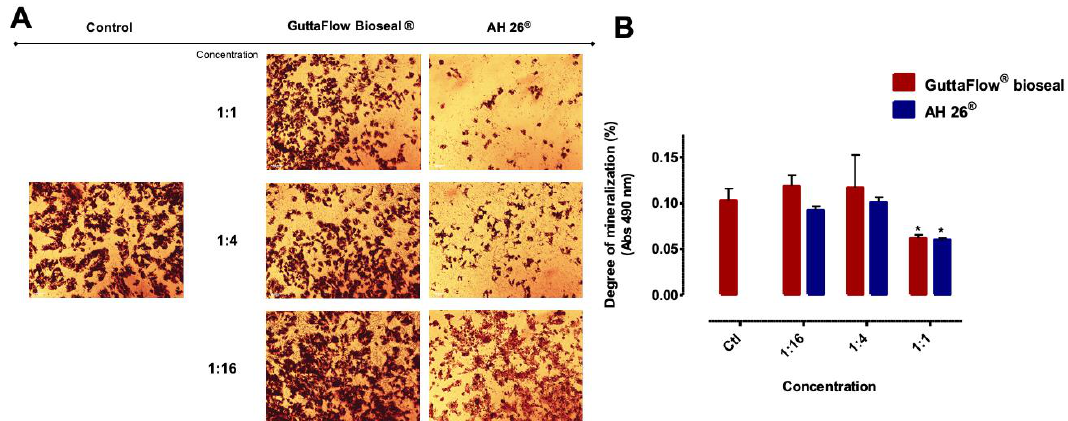
Figure 5. MDPC-23 stained cells with Alizarin Red S after 24 h of incubation with the biomaterials conditioned media ( A ) and staining quantification ( B ). The control group represents cells in culture in Dulbecco’s Modified Eagle’s Medium (DMEM) with 5% fetal bovine serum (FBS). The results are presented as the mean and standard error, with a minimum of six independent assays. Statistically significant differences to the control or between conditions are represented by a *, where * means p < 0.05.